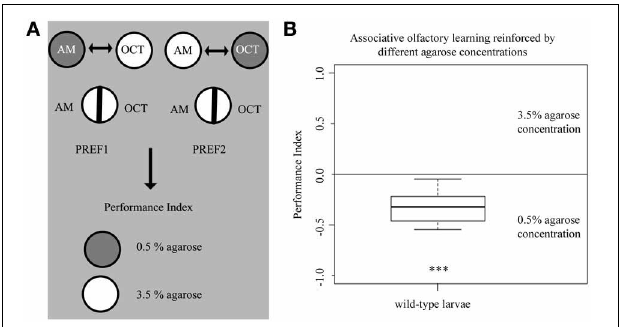
FIGURE 7 | Different agarose concentrations can be used as reinforcers for larval associative olfactory learning. (A) Overview of the experimental setup for testing larval associative olfactory learning reinforced by agarose concentrations of 0.5 and 3.5%. (B) Wild-type larvae significantly avoid an odor presented on a 3.5% agarose substrate over a second odor presented on a 0.5% agarose substrate ( p < 0 . 001). Thus, the agarose concentration of the substrate by itself can serve as a punishing and/or rewarding stimulus. A significant difference for each group against random distribution is shown below each box-plot. Sample size n > 12. ∗∗∗ p < 0 .